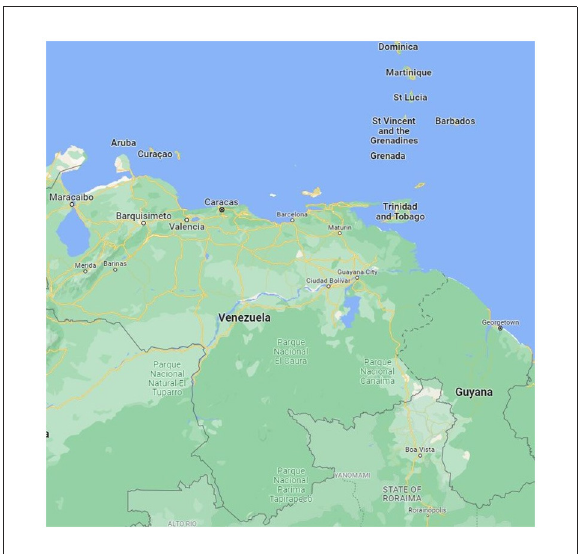
FIGURE1 Map showing location of Trinidad and Tobago and Venezuela.